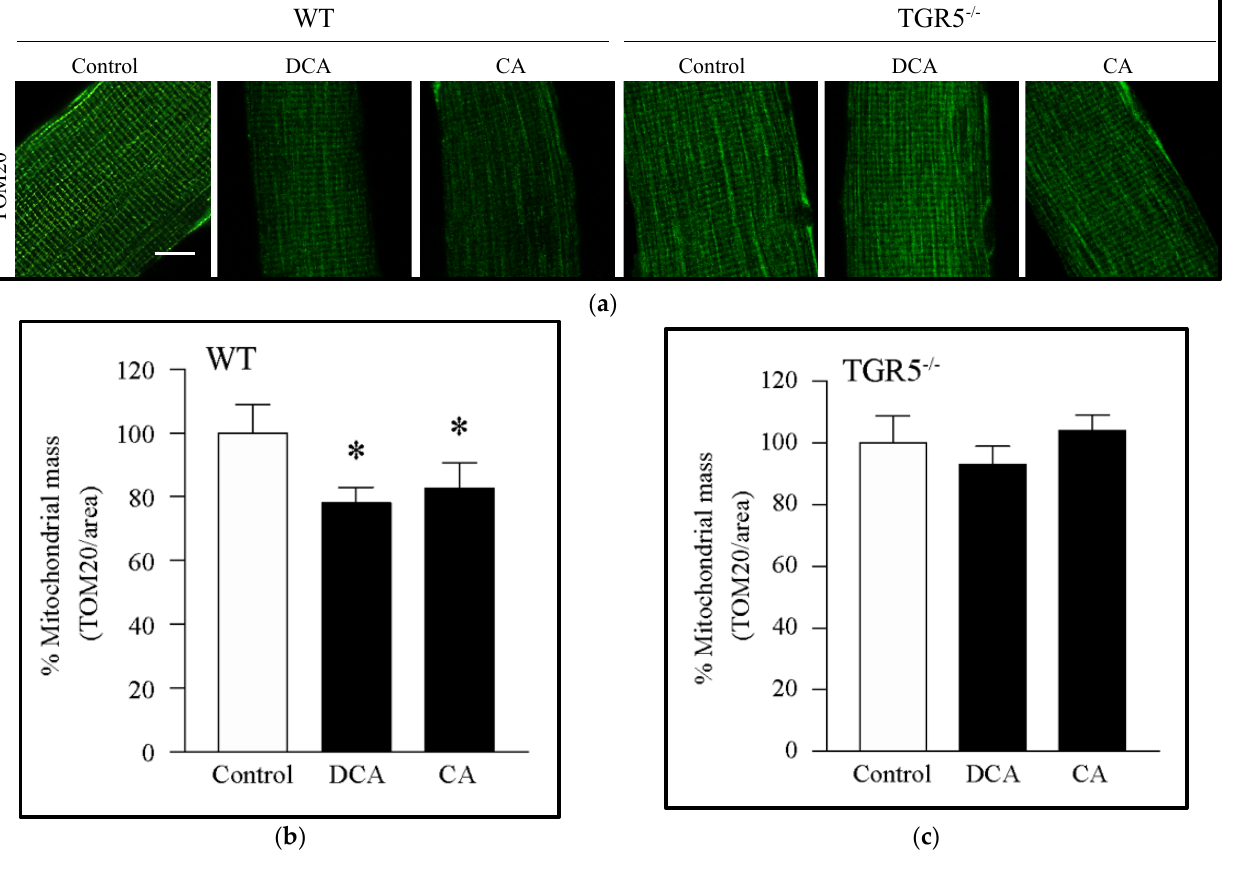
Figure 1. Decreased mitochondrial mass induced by deoxycholic acid (DCA) and cholic acid (CA) in muscle fibers involves a TGR5-dependent mechanism. Extensor digitorum longus (EDL) muscle fibers from WT and TGR5 − / − mice were incubated with DCA or CA for 72 h. Then, indirect immunofluorescence for TOM20 was performed. ( a ) Representative images for TOM20. Scale bar = 50 µm. ( b , c ) Analysis of TOM20 immunostaining to quantify mitochondrial mass expressed as a percentage in WT (b) or TGR5 − / − ( c ) fibers. Values correspond to the means ± SEM ( n = 3, * p < 0.05 vs. control condition; one-way ANOVA and Tukey’s multiple comparison test).